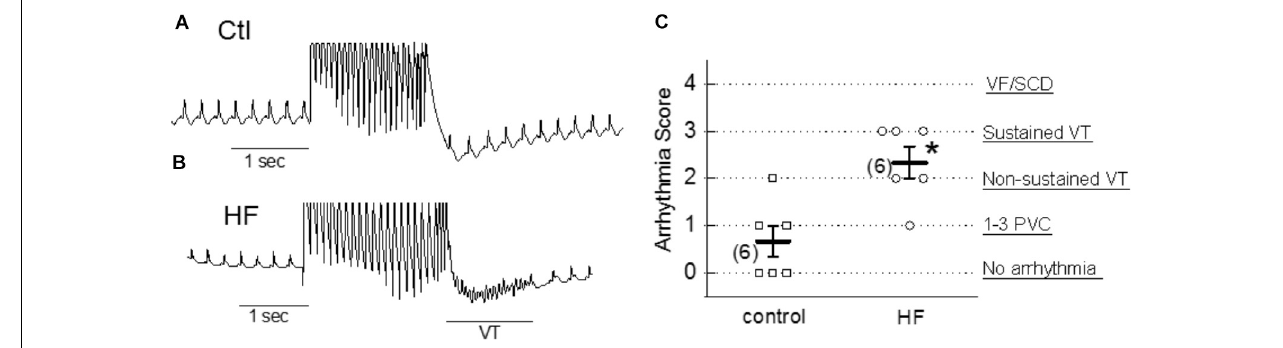
FIGURE 7 | Proarrhythmic effect of hyperforin in ex vivo hearts. (A,B) Pseudo-Lead II ECG signals recorded from control (ctl) and 20 min after perfusion with 100 nM hyperforin (HF). Programmed S1–S2 stimulations were applied to evaluate the vulnerability to arrhythmias in each case. Sustained VT was observed in HF-treated heart. (C) Summarized arrhythmia scores for control and hyperforin groups, ∗ p < 0.05, compared to